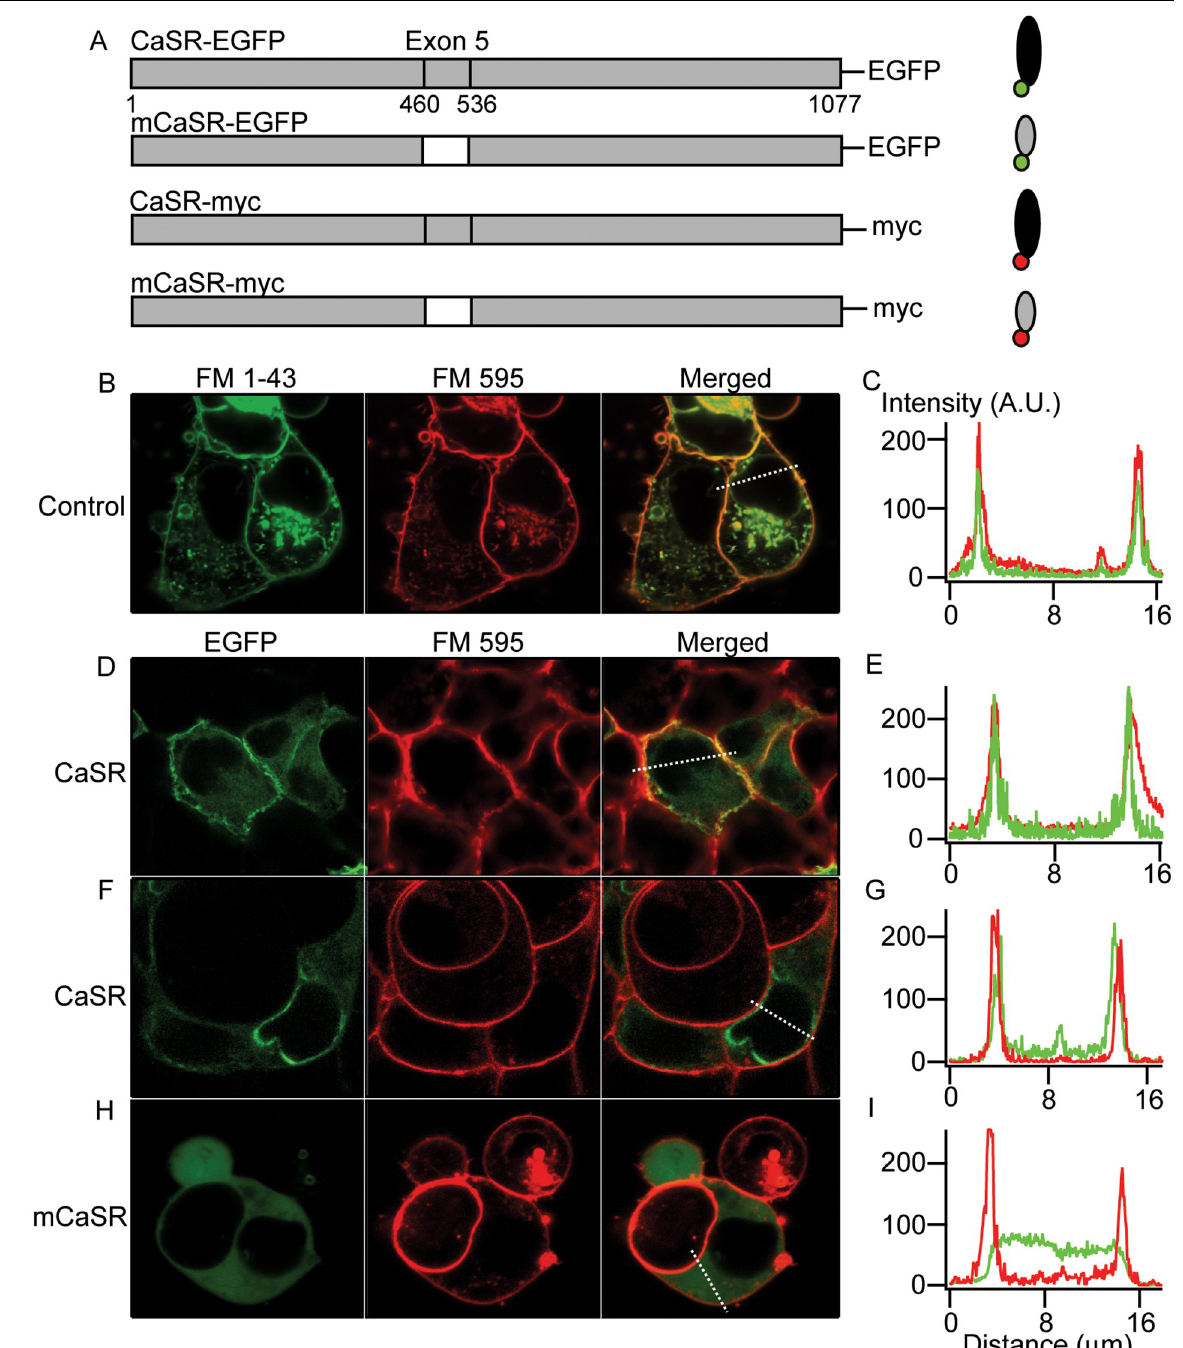
Fig 1. CaSR but not mCaSR is trafficked to the cell membrane in HEK cells. A, schematic representation of the CaSR constructs utilized. Deleted exon 5 was shown in white with construct sequence in gray. Numbers under diagrams for the full-length protein designate the first and last amino acid of CaSR (1–1077), and the first and last amino acid of CaSR exon 5 (460–536). EGFP or myc epitope tag was added to the C terminus of individual proteins. B, confocal images of living HEK cells co-labeled with red and green FM dyes, that fluoresce when bound to lipid, show superposition in the merged channel due to minimal refractive error. C, relative intensity of both fluorophores along line of interest (white broken line) in merged channel from B. D-G, two examples showing that the majority of CaSR-EGFP in HEK cells is sharply co-localized with FM-595 indicating it is targeted in or close to the cell membrane in confocal images. H, mCaSR is fairly uniformly distributed throughout the HEK cell with minimal overlap with FM-595 fluorescence. I, the line of interest indicates that the relative intensity of the EGFP signal is substantially reduced when the fluorescence from FM-595 increases indicating minimal mCaSR-EGFP in the cell membrane.